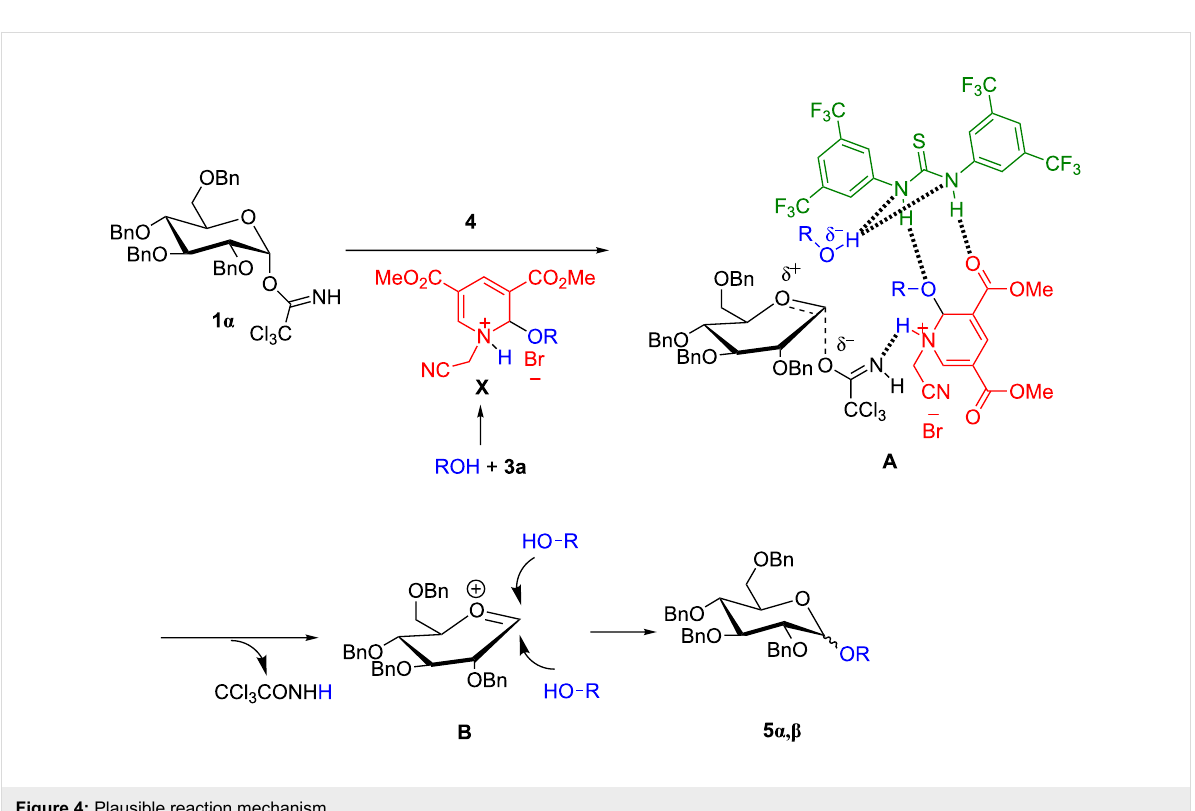
X to form an oxocarbenium intermediate B . Further, the nucleo- philic attack of the acceptor to the oxocarbenium ion B would produce the desired glycoside 5 . Higher α -selectivity may be at- tributed to the anomeric